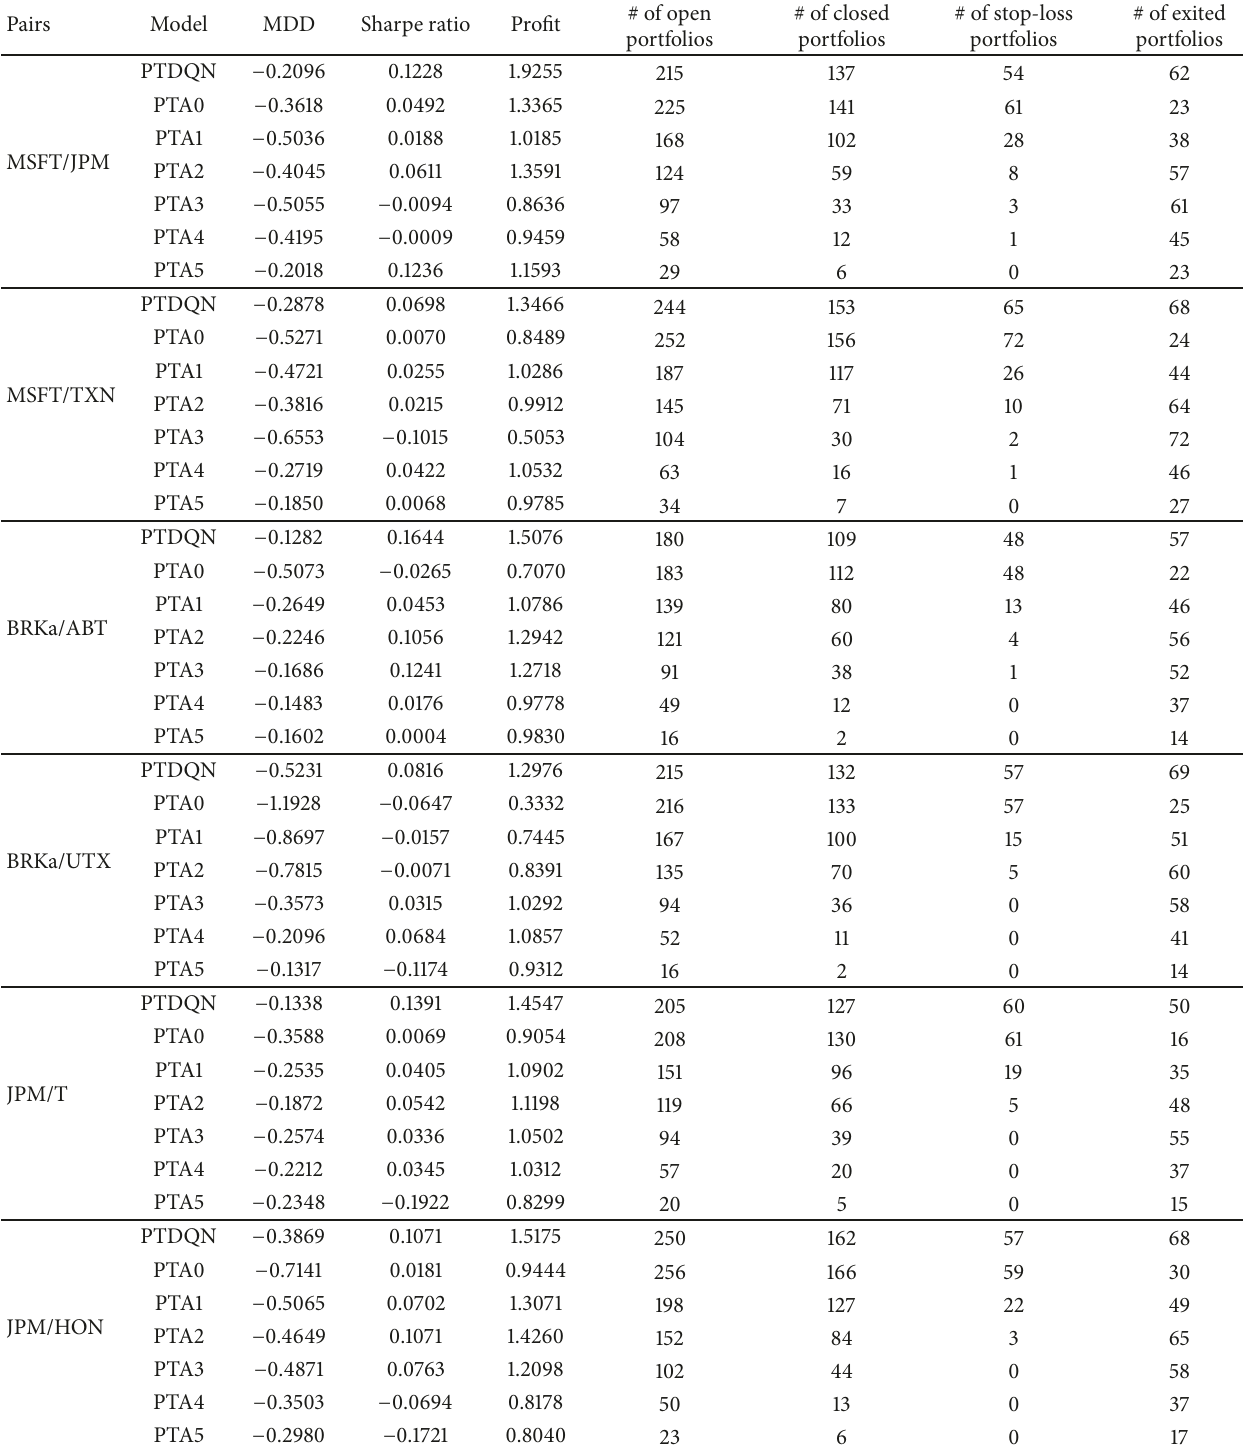
Table 9: Average top-5 performance results of the proposed method and the traditional pairs-trading strategy in the out-of-sample dataset using